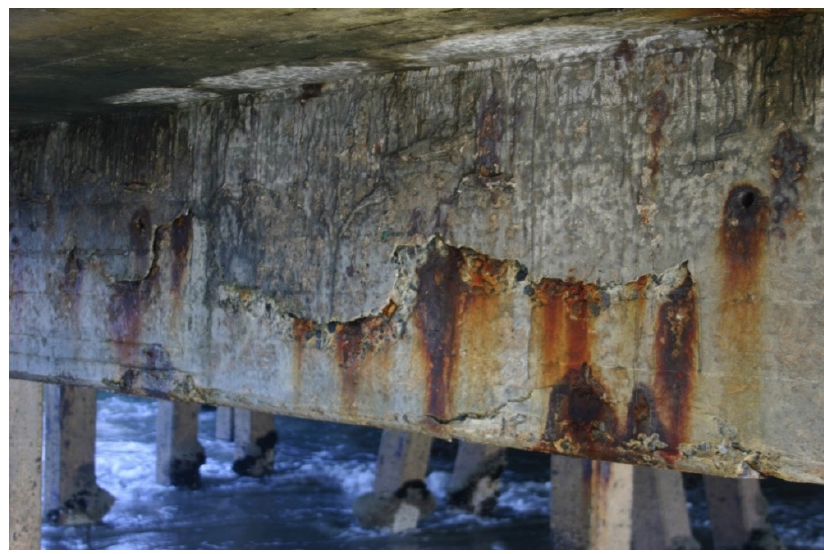
Figure 3. Steel corrosion damage in the splash and spray zone: concrete jetty on the Southern African west coast (age: ca. 50 years).